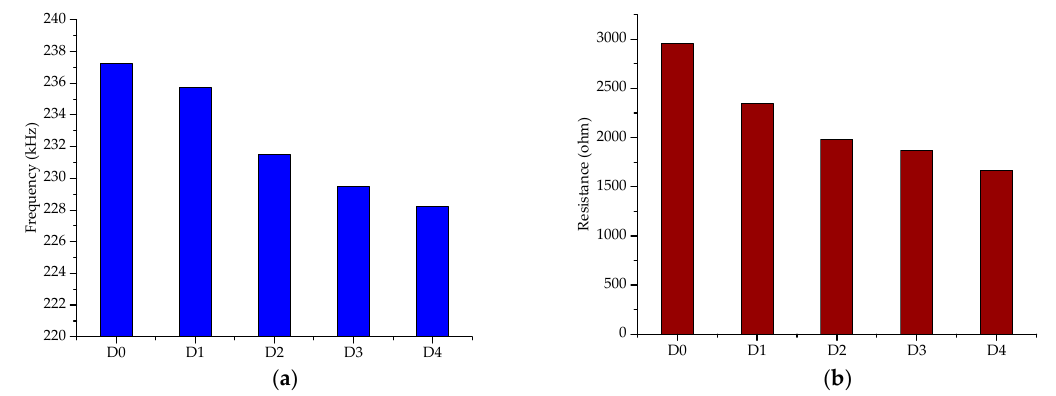
Figure 8. Changes in the peak resistance and frequency corresponding to the peak resistance with the different debonding damage states at PZT-1. ( a ) Changes of frequency corresponding to the peak resistance; ( b ) changes in the peak resistance.